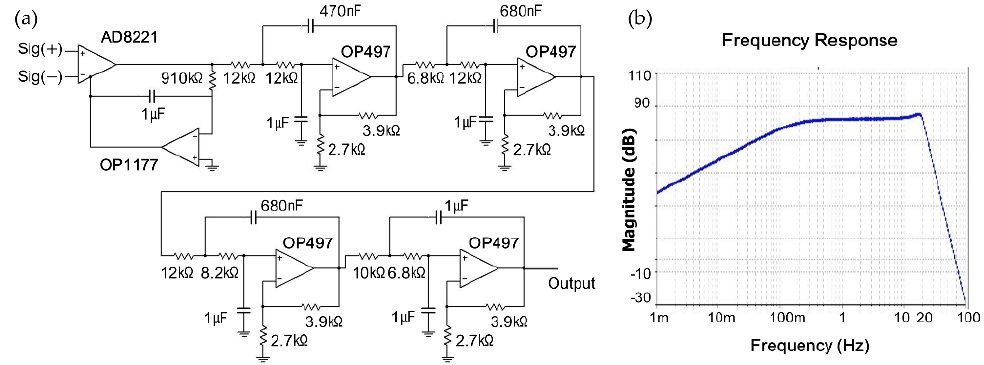
Figure 2. ( a ) Schematic diagram of signal processing circuit for the load-cell sensor; ( b ) Simulation results of frequency response of signal processing